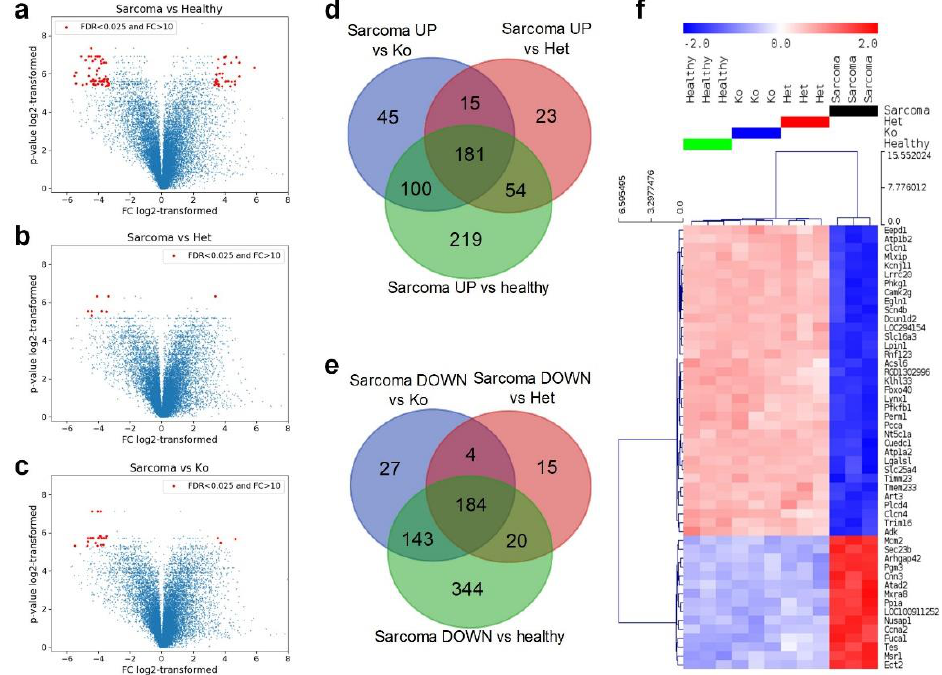
Figure 4. Comparison of gene expression and its overlap in four groups of rats. Volcano plots of gene expression in rats with sarcoma and all other groups: healthy ( a ), heterozygous knockout ( d ), total knockout ( c ). In panels ( a – c ), the horizontal axis presents log2-transformed fold change of gene expression, while the vertical axis presents log2-transformed p -value (after FDR correction). Venn diagrams of genes upregulated in sarcoma rats versus healthy controls and rats with heterozygous and total knockout ( d ), genes downregulated in sarcoma rats versus healthy controls and rats with heterozygous and total knockout ( e ). Hierarchical clustering of the top 50 differentially expressed genes (lowest FDR in ANOVA), Euclidean distance, linkage method: average, row-standardized ( f ). Table 1. Number of genes differentially expressed (FDR < 0.05) in pairwise comparisons between groups. Genes Upregulated In: Healthy Het Ko Sarcoma